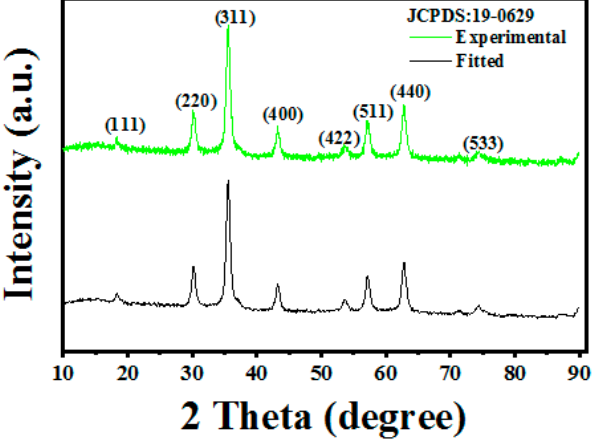
Figure 3. XRD pattern of the C-Fe 3 O 4 nanoparticles.